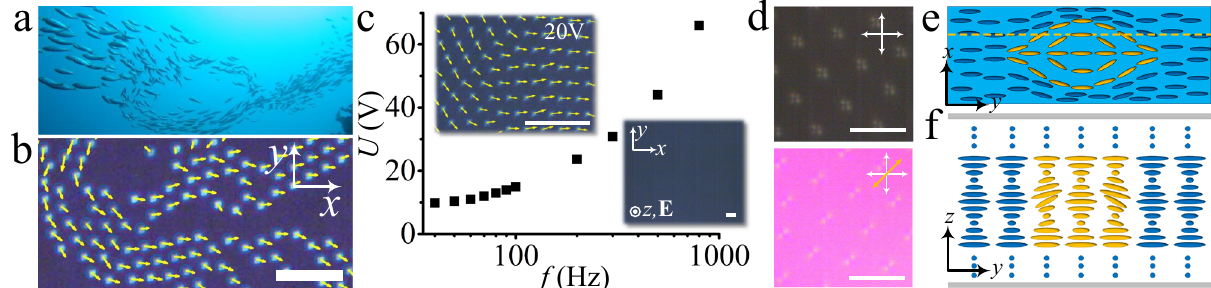
Fig. 1 Collective motion of directrons. a Photograph of schools of fi sh. Figure from Joanna Penn, Flickr: https://www. fl ickr.com/photos/38314728@N08/ 3997721496/in/dateposted/ [reproduced by permission]. b Polarizing micrograph of collectively moving directrons with their velocities indicated as yellow arrows. U = 16 V, f = 100 Hz. Scale bar 50 μ m. The polarizers are parallel to the x - and y -axes, respectively. c Frequency dependence of the threshold for generation of directrons. The insets show the micrographs below (0 V) and above the thresholds ( U = 20 V, f = 100 Hz) of the generation of the directrons. The y ellow arrows represent the velocities of the directrons. Scale bars 50 μ m. d The polarizing micrographs of directrons at f = 100 Hz, U = 20 V. Scale bars 20 μ m. The white crossed arrows represent the polarizers, and the yellow arrow represent the optical axis of the λ -plate. e The schematic director structure of a directron in the middle layer of the chiral nematic sample. f The schematic director structure of a directron in the yz plane of the cross section along the dashed yellow line in e . The director fi eld within the directron is represented as yellow ellipses and the homogeneous director fi eld outside the directron is represented as blue ellipses. The top and bottom sections of the sample in f are homogeneously aligned helical structures and are represented by blue